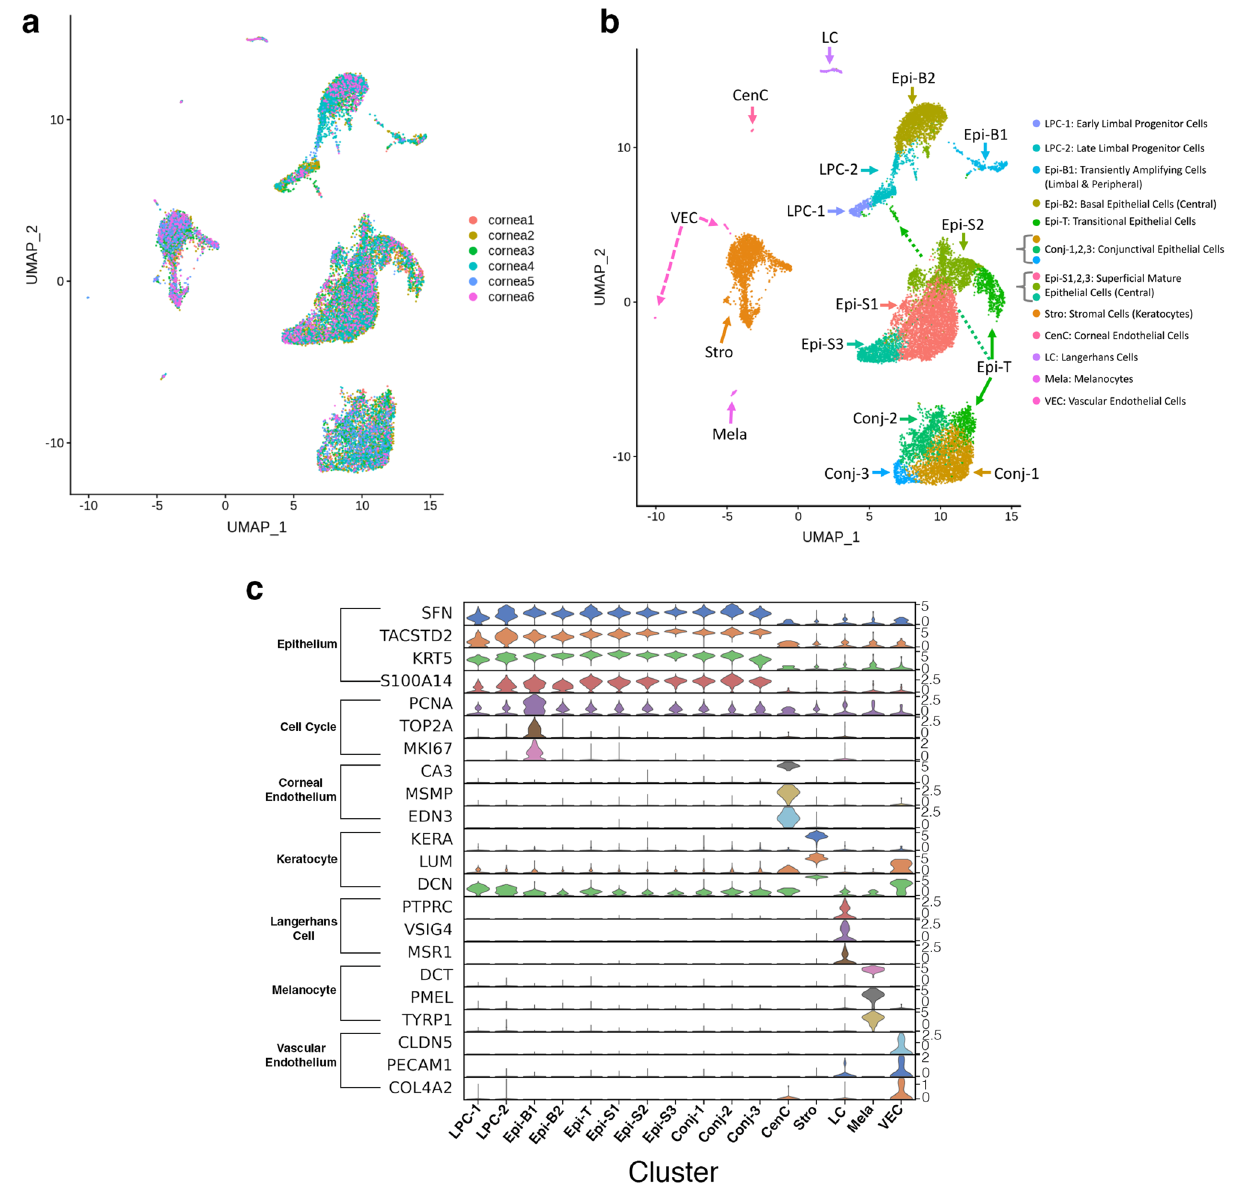
Figure 1. Sixteen clusters of cells were identified in the healthy adult human cornea. (a) UMAP visualization of the contribution of each of the 6 cornea samples. (b) UMAP visualization of the 16 clusters. Individual points correspond to single cells colored according to clusters identified. (c) Violin plot of marker gene expression in each cluster. Cell type related marker genes are listed on the left and cell types identified based on marker gene expression are labeled at the bottom. Clusters Conj-1–3 are conjunctival epithelial cells, LPC-1, 2, Epi-B1, B2, T, S1-3 are corneal epithelial cells, Stro are keratocytes, LC are Langerhans cells, Mela are melanocytes, VEC are vascular endothelial cells, and CenC are corneal endothelial cells. SCANPY 1.7.1 in Python was used to generate the violin plots as indicted in the "Materials and methods" (https:// pypi. org/ proje ct/